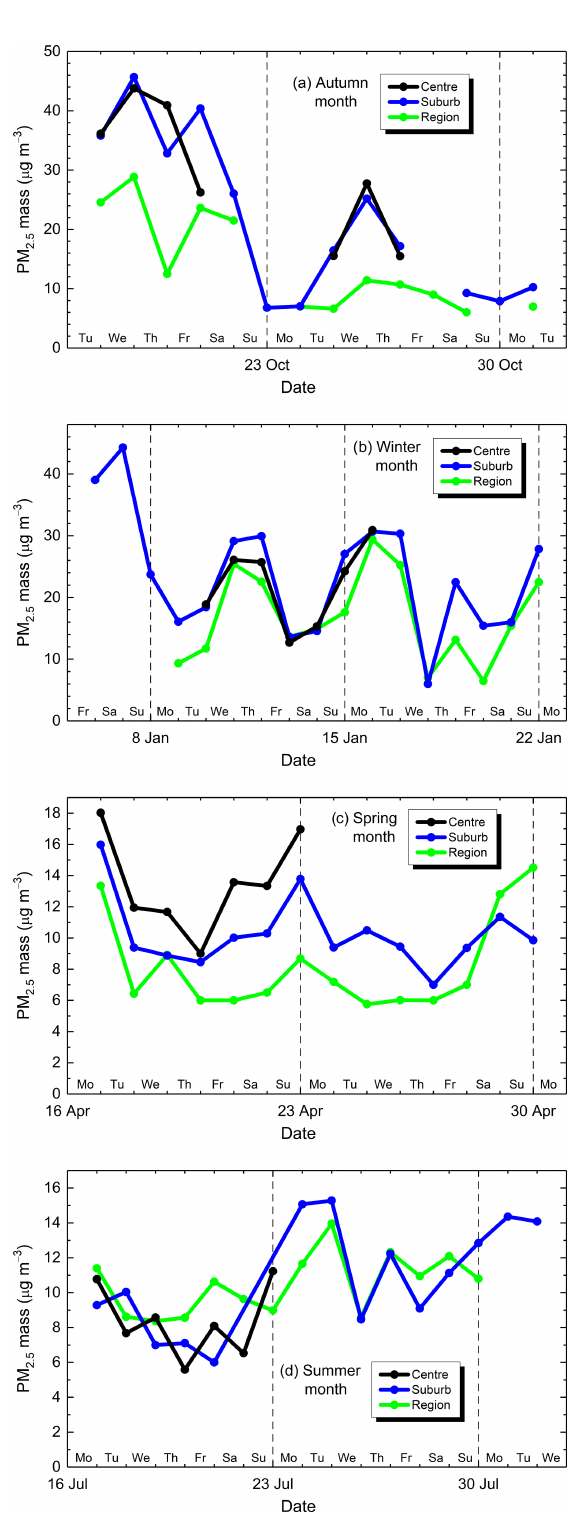
Figure 2. Time variation of PM 2 . 5 mass for regional background in the Carpathian Basin, suburban area and city centre of Bu- dapest during the aerosol sampling time intervals for different months (a–d)